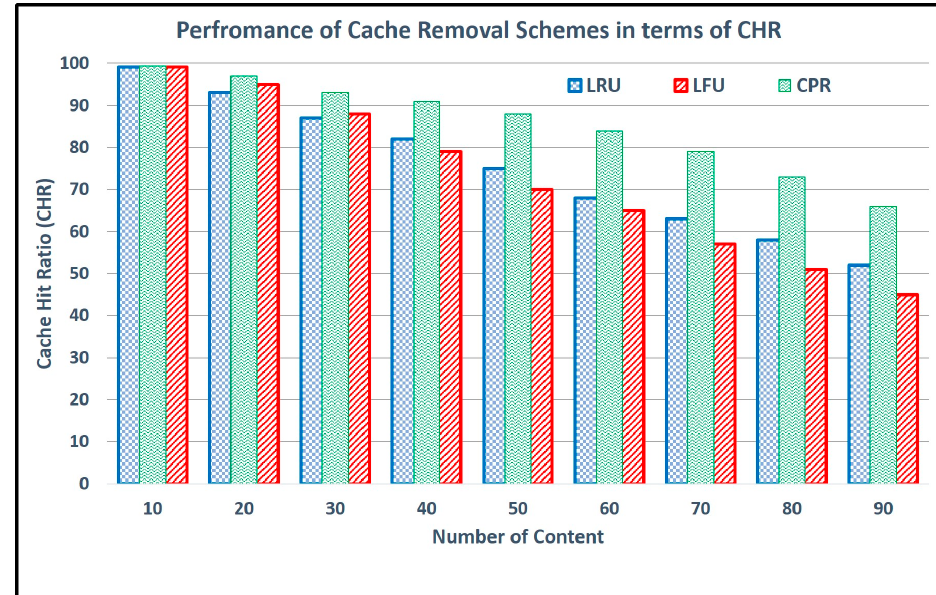
Figure 3. Cache hit ratio against increasing number of